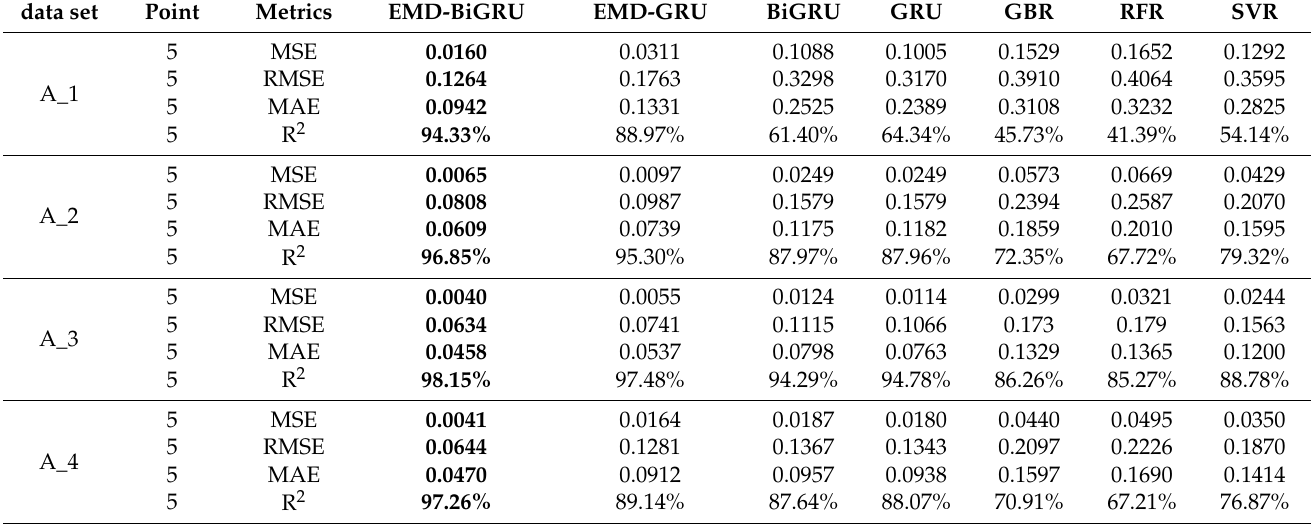
Table 2. Comparison results of different models for the data